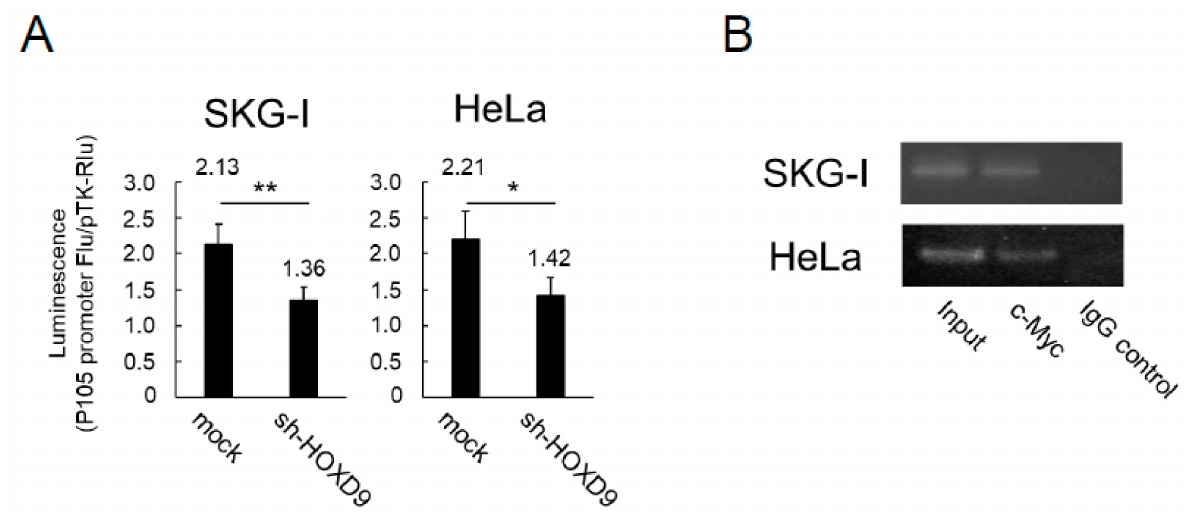
Figure 4. HOXD9 binds directly to the P105 promoter and regulates function. ( A ) Relative luciferase activities of P105 promoter reporters in vector control (mock) and HOXD9 -knockdown CC cells (sh-HOXD9). Data are expressed as the mean ± SD of three replicates. ( B ) Binding of HOXD9 to the P105 promoter was analyzed by a ChIP assay, as described in the Materials and Method section. * p < 0.05, ** p <